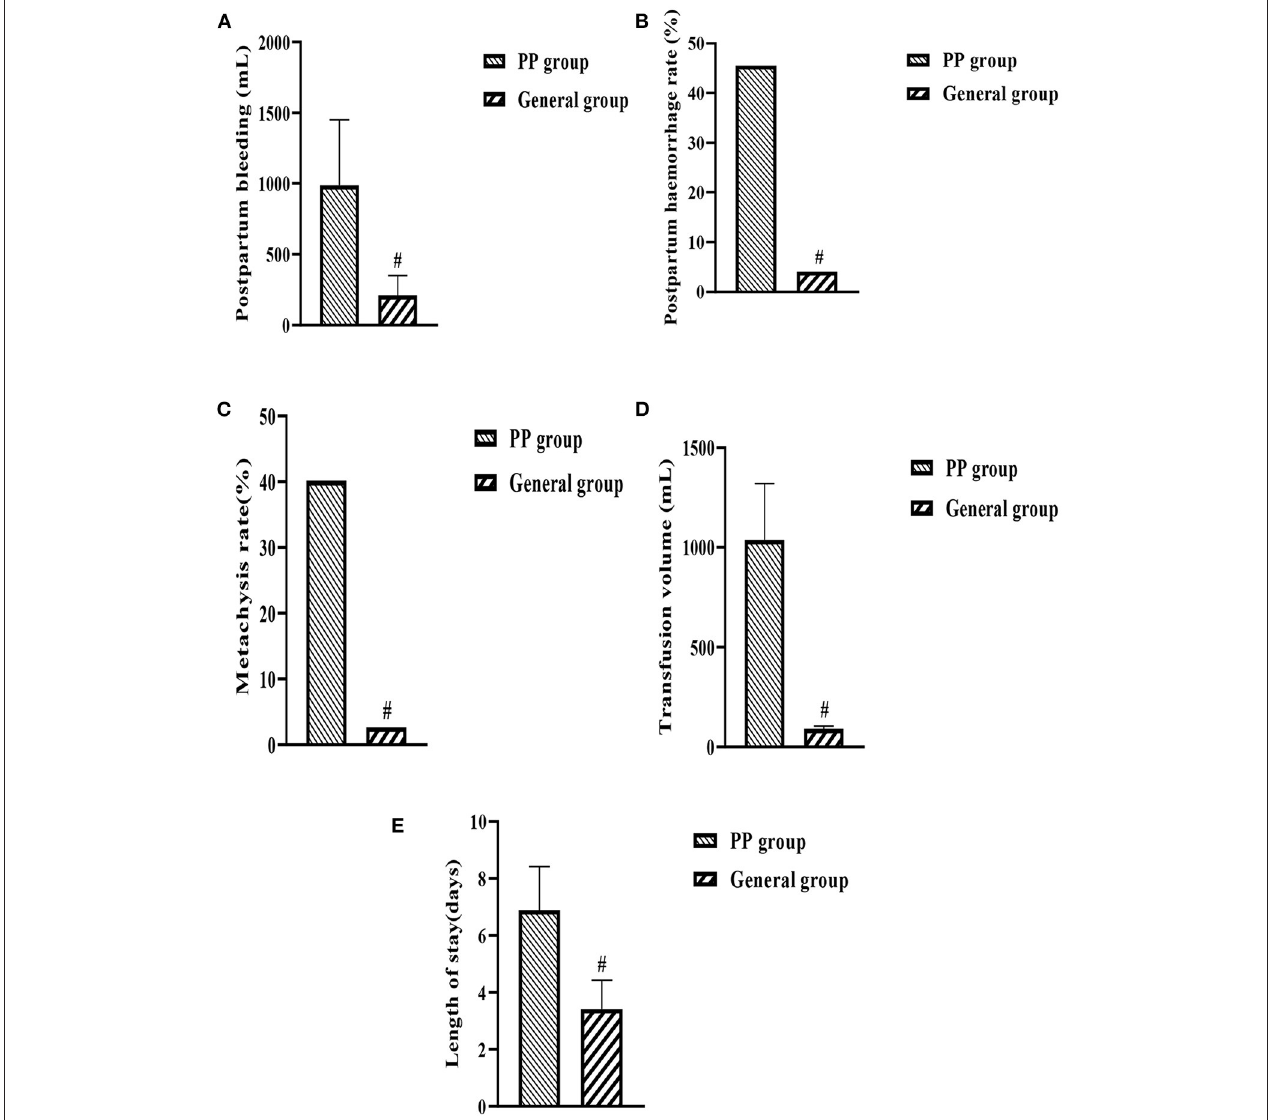
FIGURE 2 | (A–E) Histogram of maternal postpartum conditions in both groups. # indicates comparison between two groups, P < 0.05.